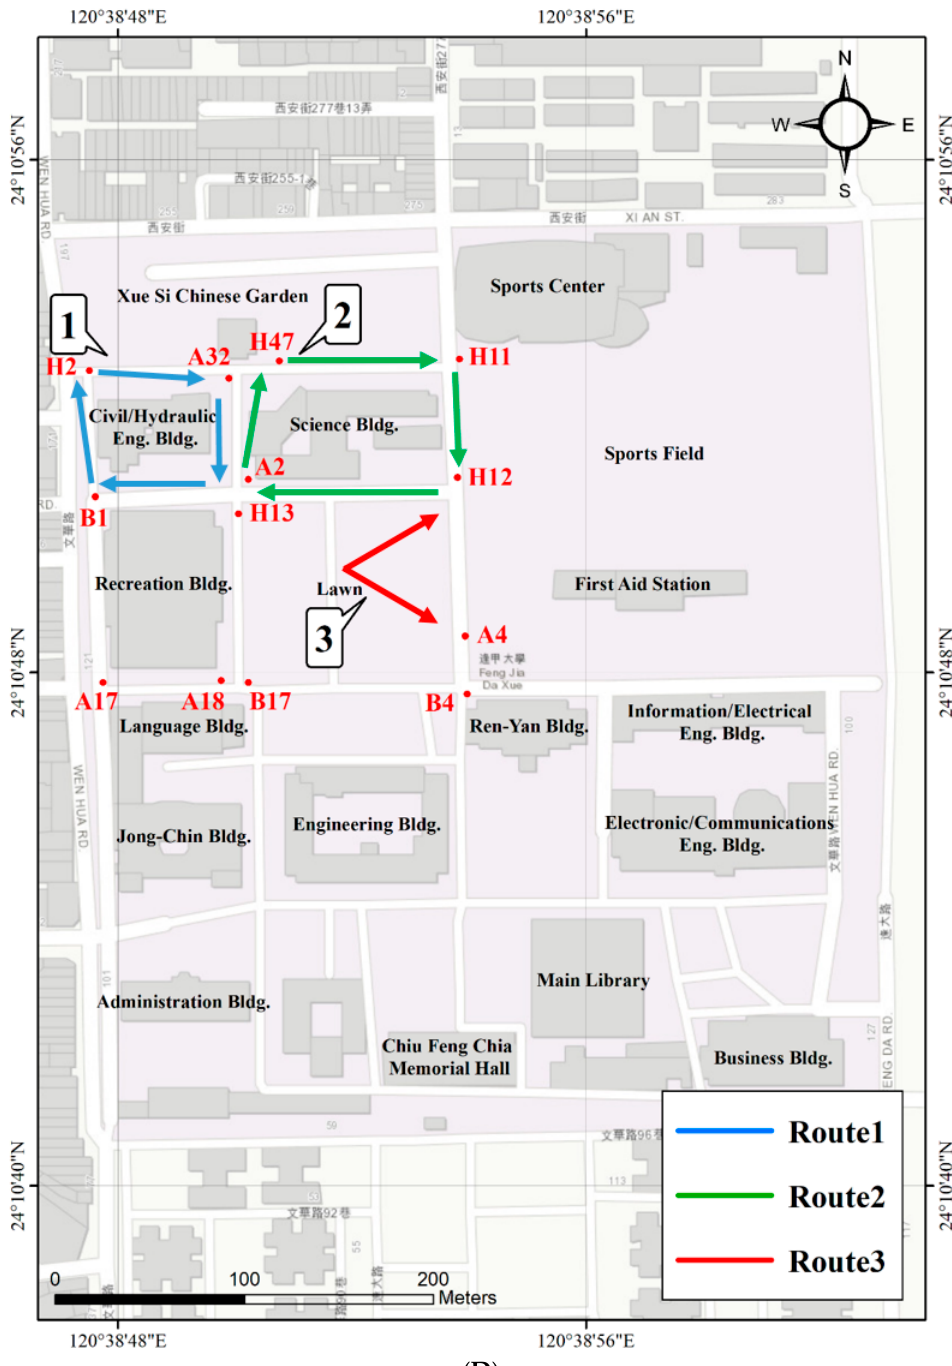
Figure 4. Study site ( A – C ), stations and routes ( D ) for the course of Surveying Practice in Feng Chia University (FCU), where blue and green colors indicate the routes for the elevation-based measurement, and red represents the station for the angle-based measurement.